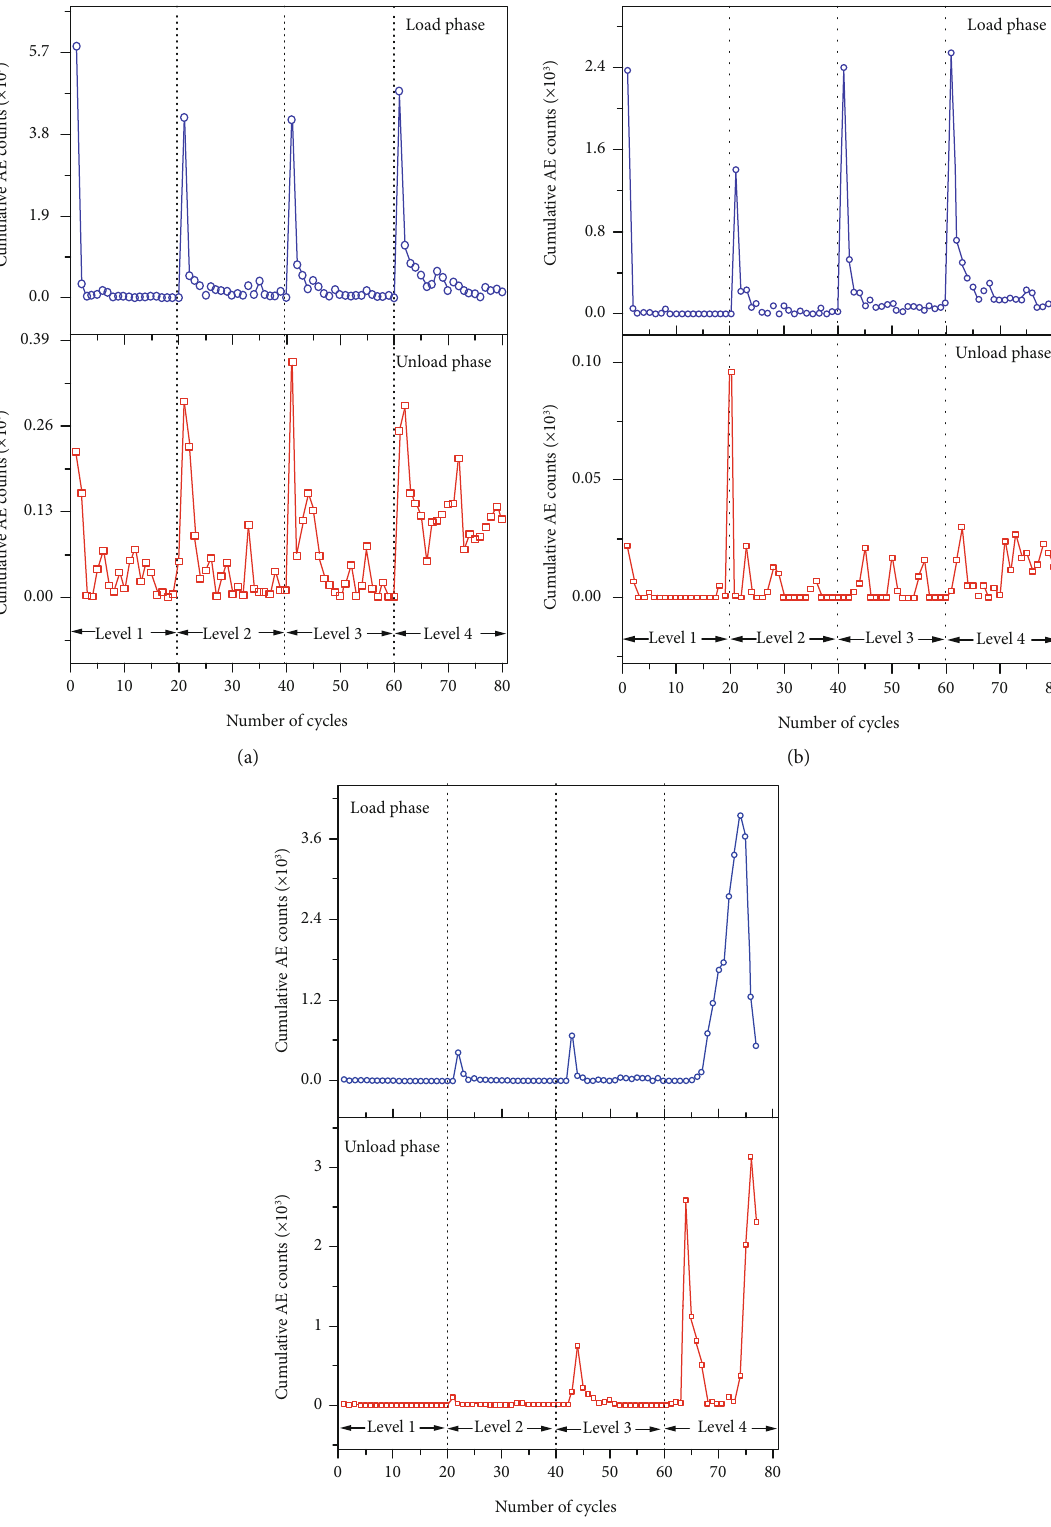
Figure 11: Evolution of cumulative AE events of coal versus cycles at di ff erent loading frequencies: (a) 0.1Hz; (b) 0.2Hz; (c)